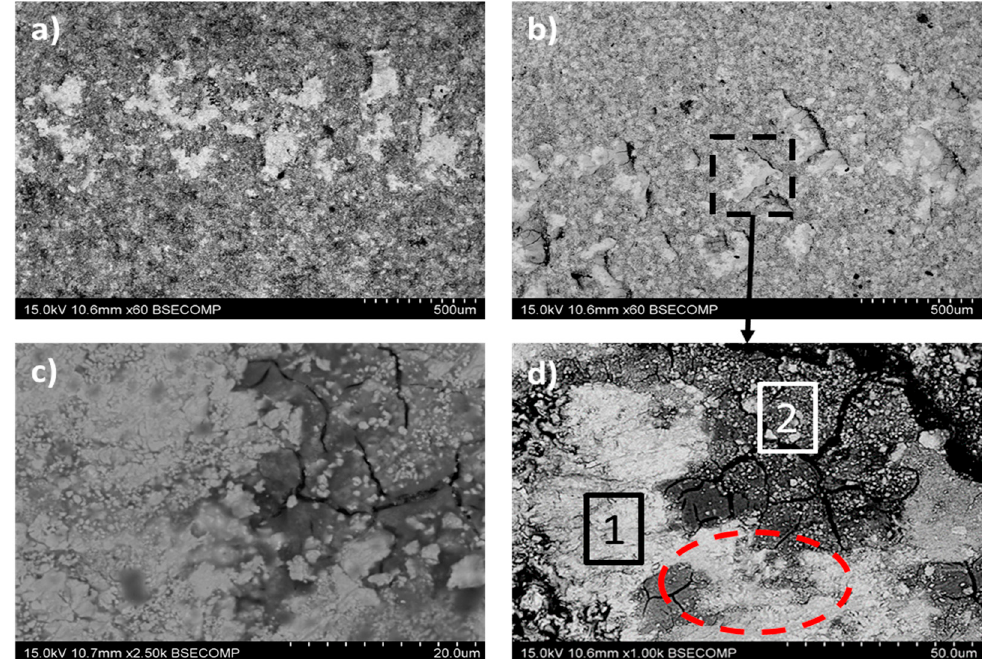
Figure 11. Backscattered SEM micrographs of the wear tracks of: ( a ) 1L-1 and ( b ) 2L-1. Higher magnifications of ( c ) 1L-1 and ( d ) 2L-1 coating.